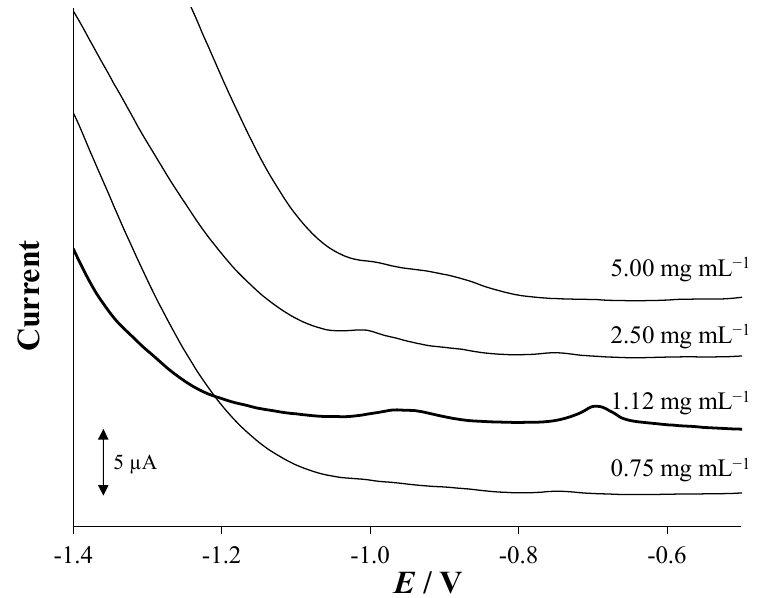
Figure 3. Effect of the concentration of the 2D Sb exf suspension drop-casted on the surface of the working electrode of the SPCNFE on the DP stripping voltammograms for 20 µg L − 1 of Cd(II) and Pb(II). Electrochemical measurements were carried out at pH 2, E d of − 1.4 V, and t d of 240 s.